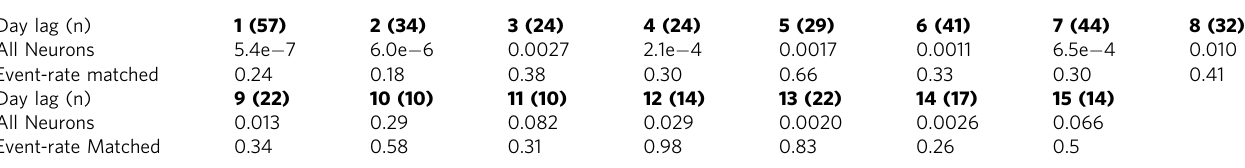
High/low reliability = stem PCs in top/bottom quartile of mean reliability value.